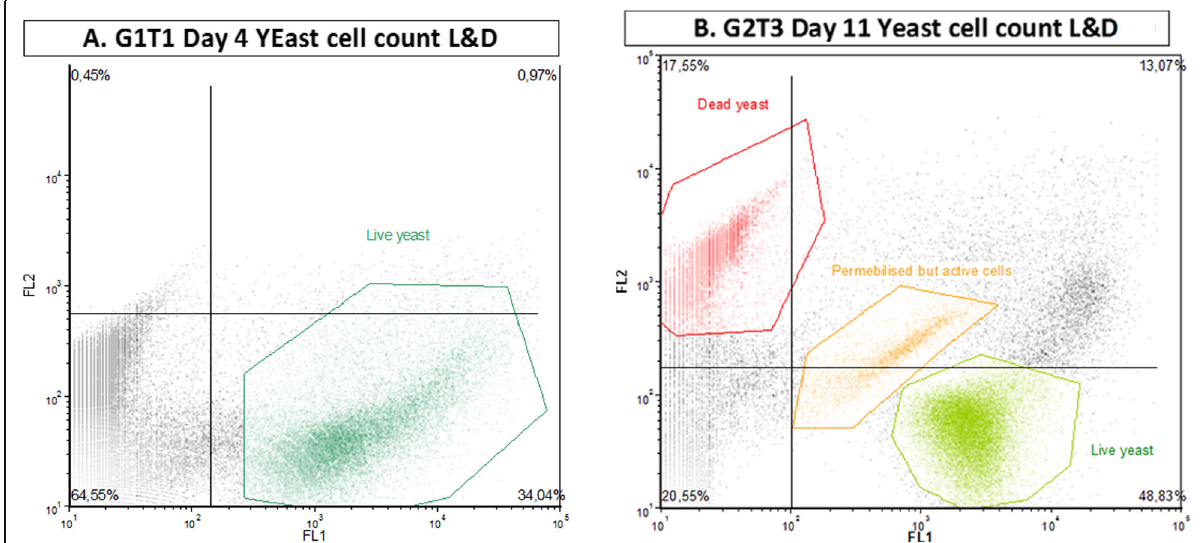
Fig. 3 Flow cytometric assay of yeast population observed during alcoholic fermentation. a Yeast population of G1T1 experiment after 4 days from the inoculum. b Yeast population of G2T3 experiment observed 11 days after the beginning of AF